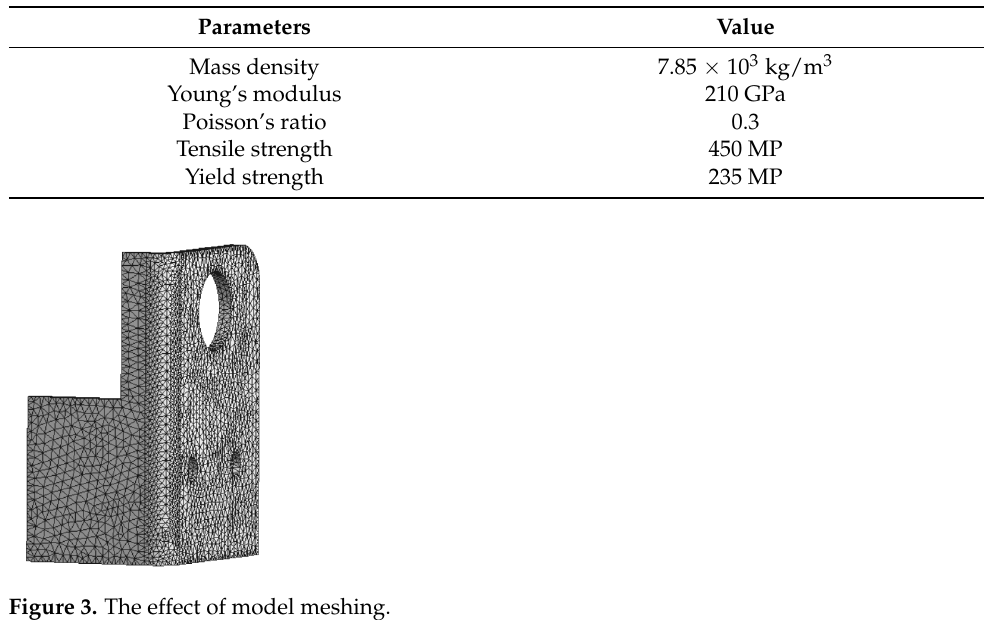
Table 1. Q235 material properties.